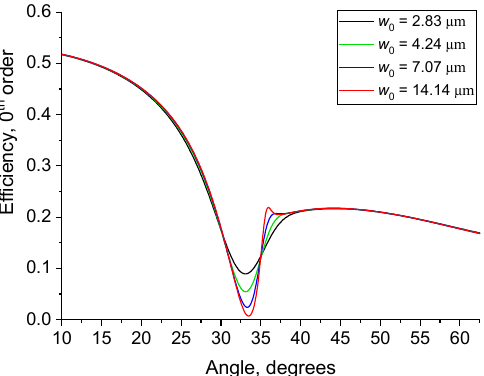
Figure 3. Calculated diffraction efficiencies of the zero-order depending on the angle of incidence for the nickel grating with a period Λ = 400 nm and depth h = 80 nm at a wavelength of radiation λ = 632.8 nm with p -polarization and different beam radii w 0 = 2.83 μ m (black line), w 0 = 4.24 μ m (green line), w 0 = 7.07 μ m (blue line), w 0 = 14.14 μ m (red line).